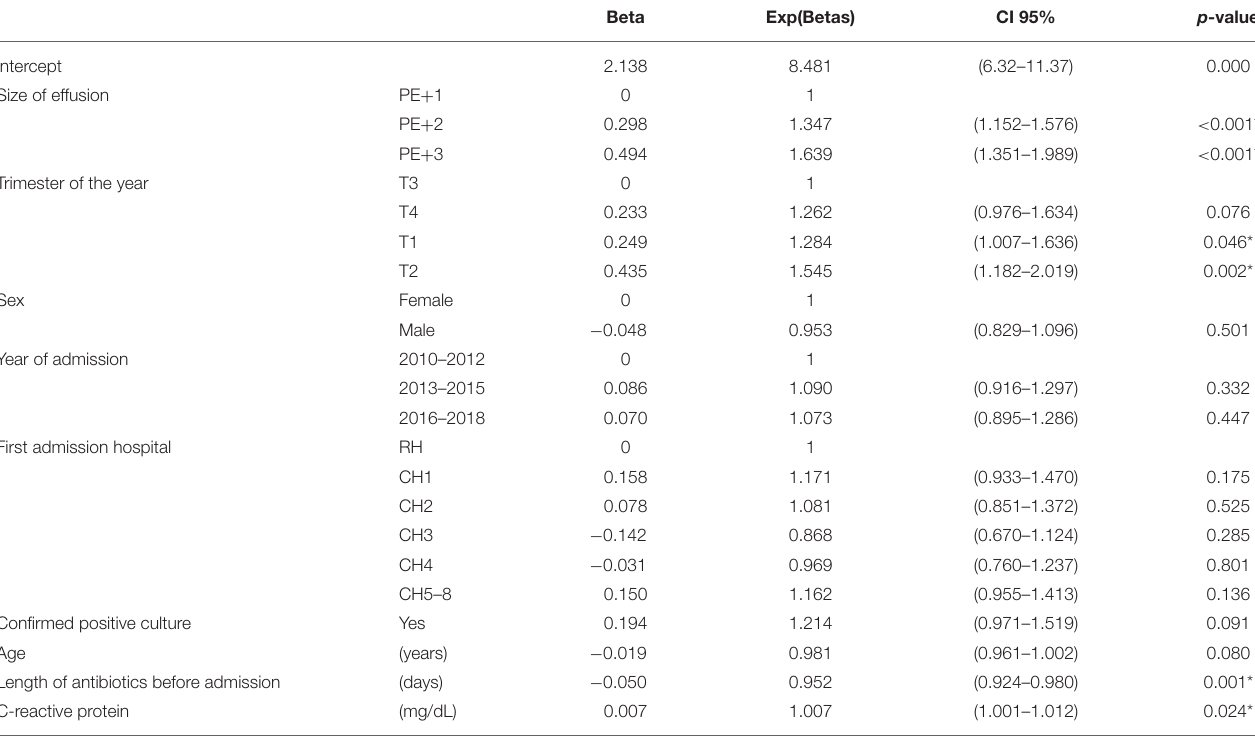
TABLE 2 | Multivariate Gamma model for the length of hospital stay for patients with PE +